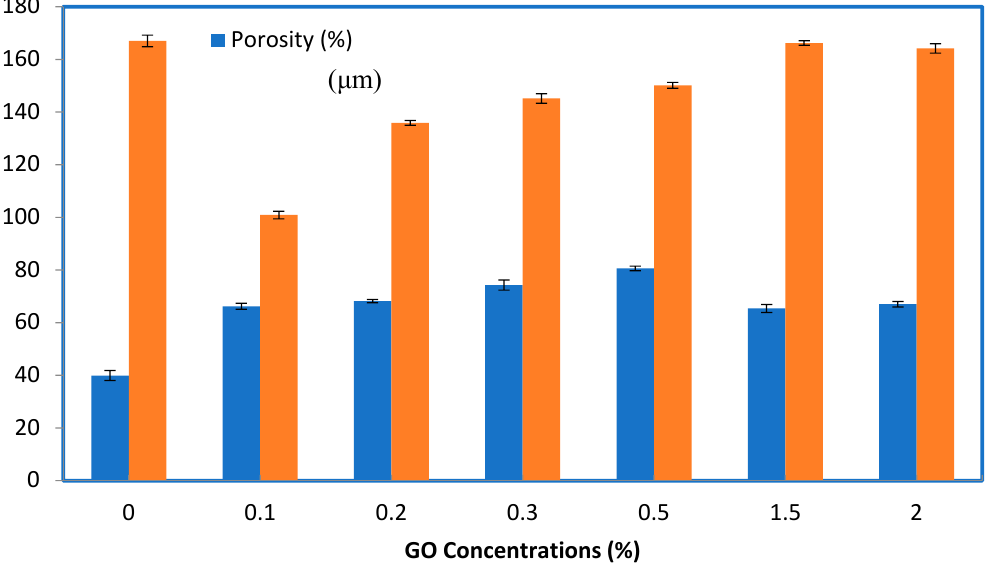
Figure 4. E ff ect of GO concentrations on the thickness and porosity of PES-based membranes. The bar height is the average of five measurements of porosity and thickness and the error bars represent ± one standard